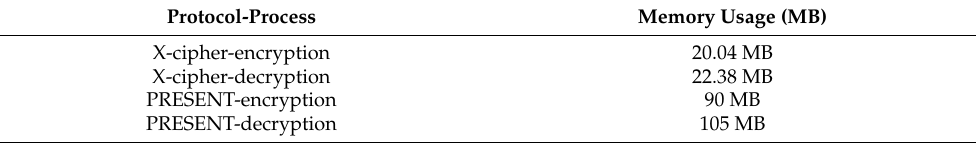
Table 5. Memory usage results in comparison between X-cipher and